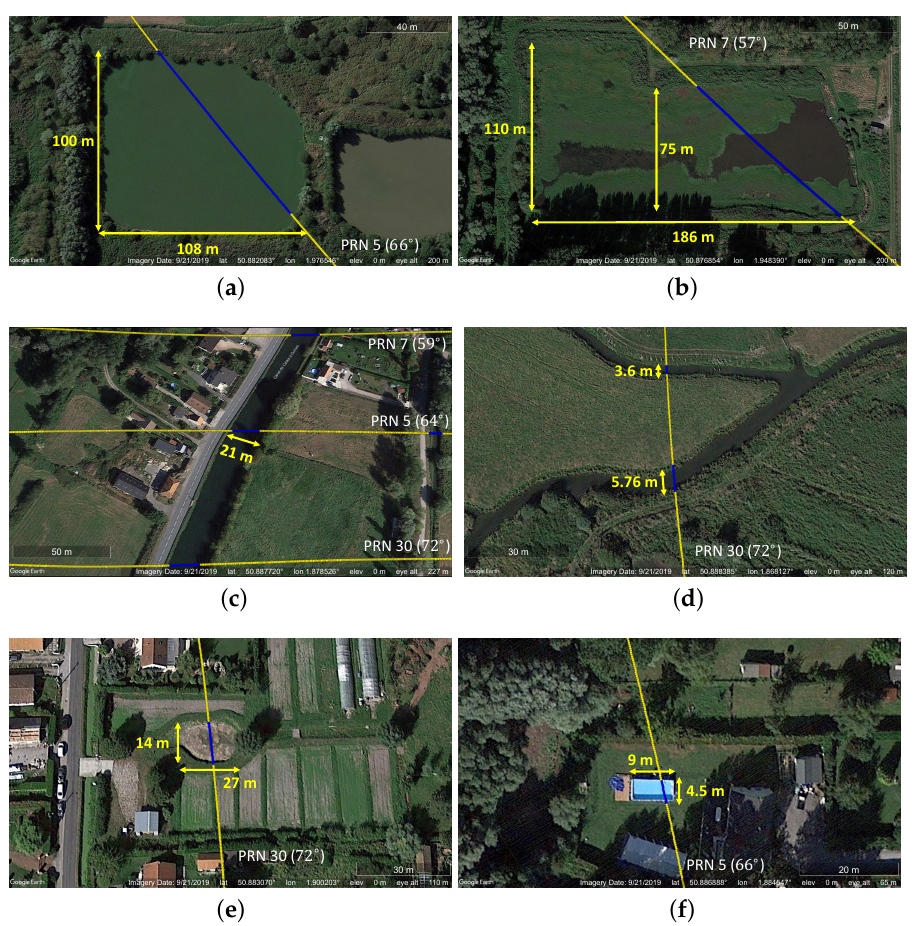
Figure 14. Detection of water body surfaces in landforms using the proposed automatic radar technique. ( a ) Lake (50.882083 ◦ N, 1.976546 ◦ E); ( b ) Swamp (50.876854 ◦ N, 1.948390 ◦ E); ( c ) River (50.887720 ◦ N, 1.878526 ◦ E); ( d ) Streams (50.888385 ◦ N, 1.868127 ◦ E); ( e ) Wetland (50.883070 ◦ N, 1.900203 ◦ E); ( f ) Pool (50.886888 ◦ N, 1.884547 ◦